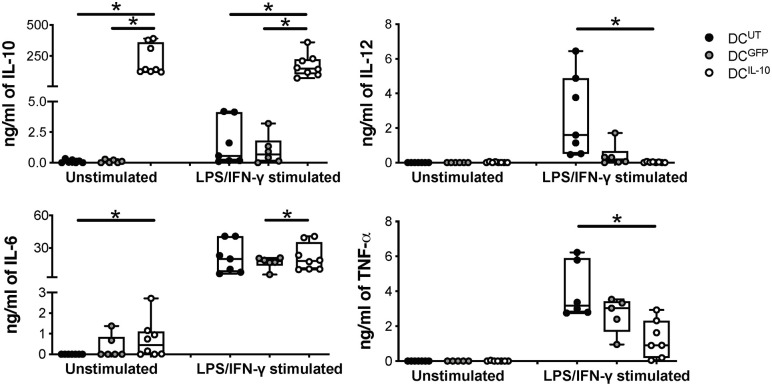
DCIL−10 secrete supra-physiological levels of IL-10 and low levels of pro-inflammatory cytokines at steady state and upon activation. At the end of differentiation, 2 × 105 DC were plated in 200 μl and left unstimulated or stimulated with LPS and IFN-γ for 48 h. Concentration levels of IL-10, IL-12, IL-6, and TNF-α in culture supernatants were evaluated by ELISA. Each dot represents a single donor (n = 6–8), lines indicate median, while whiskers are minimum and maximum levels. *P ≤ 0.05 (Wilcoxon matched pairs test, two-tailed).